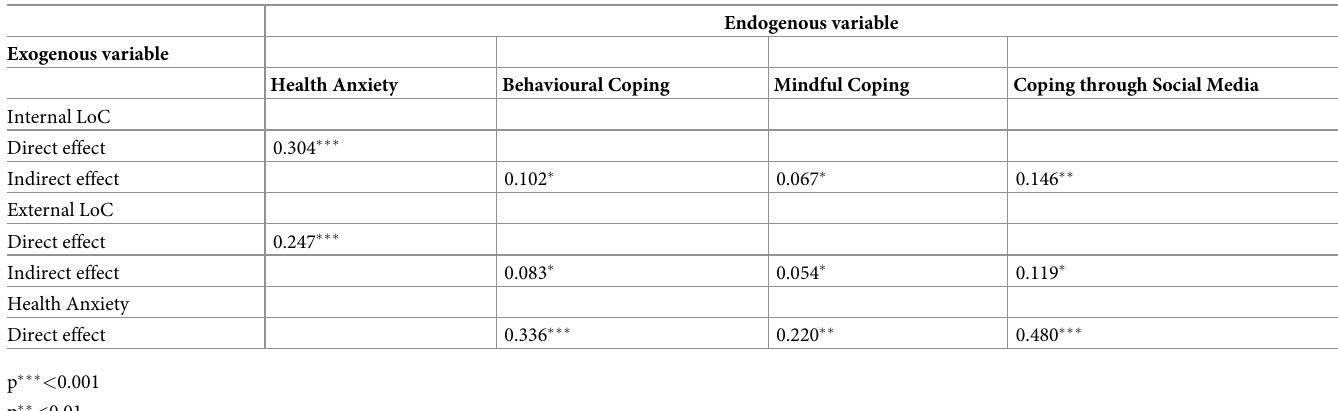
Table 4. Regression standardised structural coefficients.